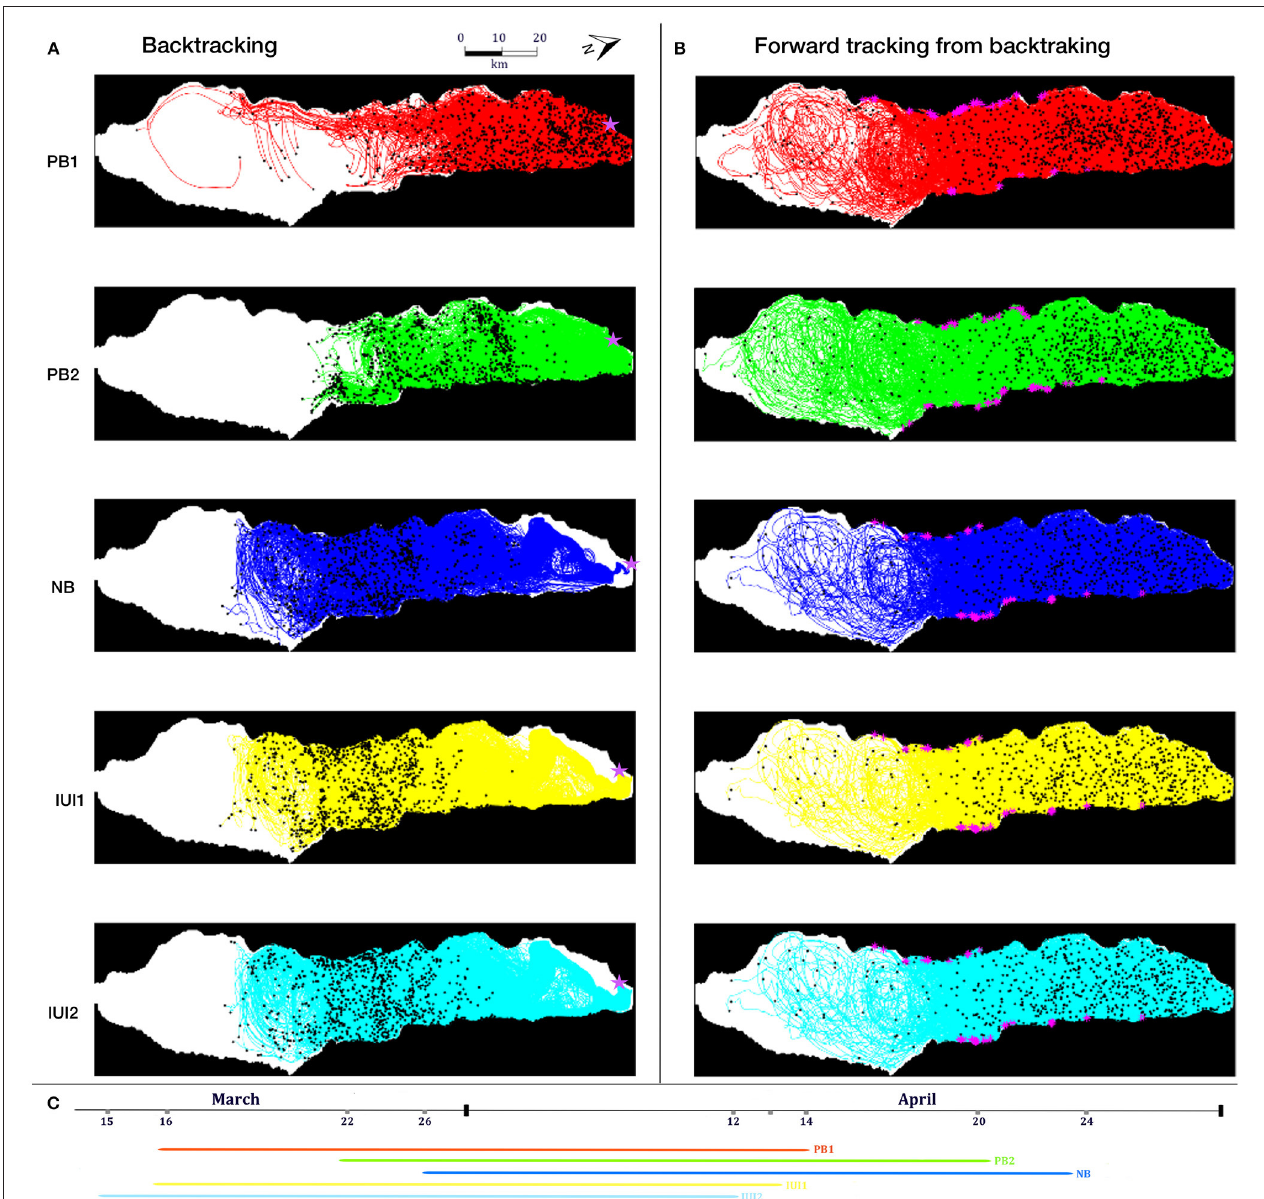
FIGURE 2 | (A) Trajectories of passive virtual larvae released at the locations and times of settlement ( n = 5,000 per site) and tracked backward in time for a duration of 28–29 days (Sim. #1, Table 1 ). Virtual larvae from (A) with final positions in the reef ( n = 244) were multiplied ( × 20) and tracked forward in time for 28–29 days (B) . Magenta asterisks in (A,B) represent particle release locations. (C) Pelagic Larval Durations (PLD) of the recruiting cohorts from April-March 2004, which were deducted from otolith analysis in Ben-Tzvi et al. (2012). Maps in (A,B) were generated using MATLAB R2014b (The MathWorks Inc., Natick, MA, USA), and are rotated views of the GoA (73 ◦